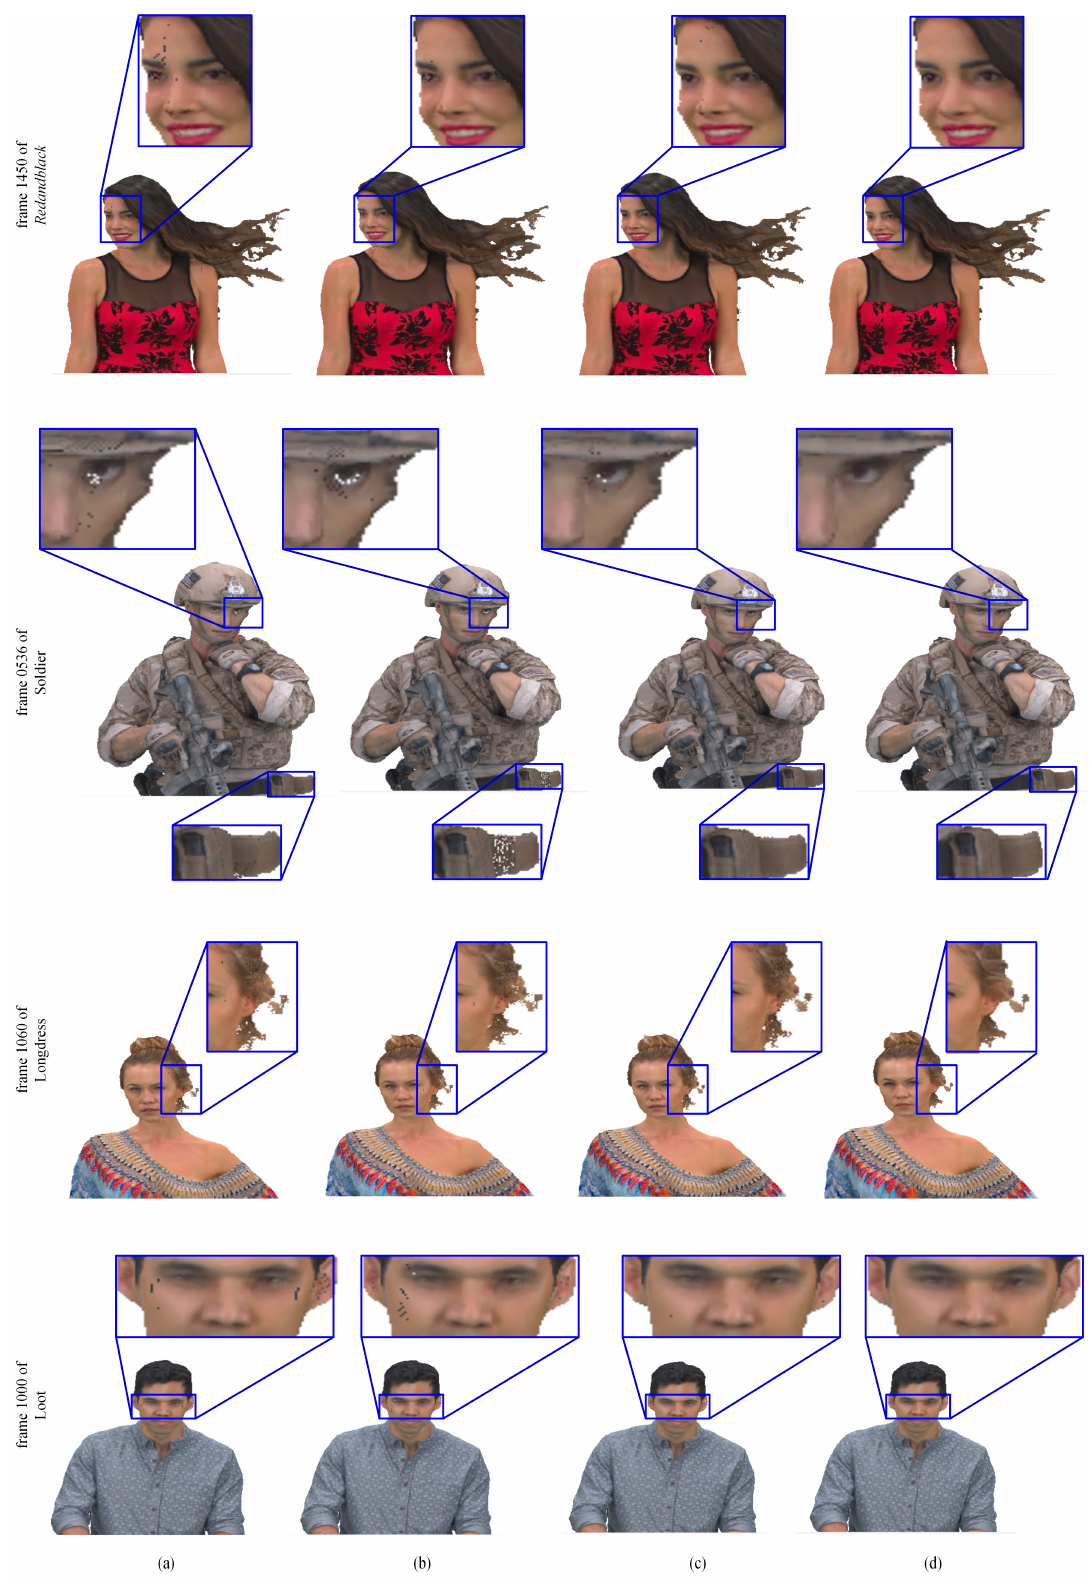
Figure 13. Results for subjective inspection in MPEG 8i dataset: ( a ) V-PCC with voxDim of 2; ( b ) V-PCC with voxDim of 4; ( c ) compressed by the curvature-grading-based refining method; ( d ) the original point clouds.